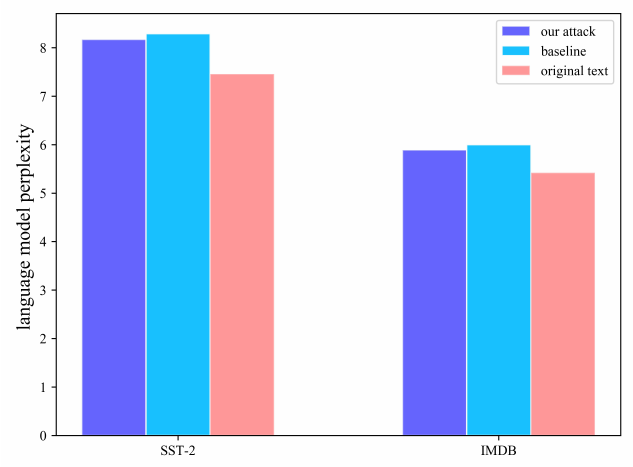
Figure 8. Language model perplexity. We utilize the language model perplexity to measure the fluency with the help of GPT-2 . The y-coordinate is in log-2